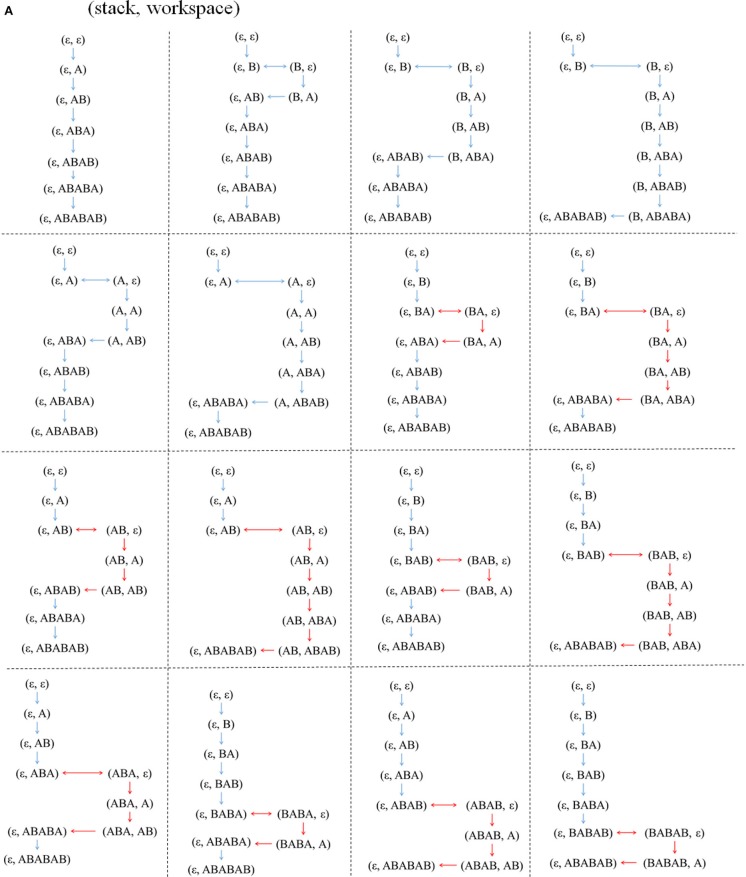
Examples (portion) of state transitions to make a product ABABAB using non-RCs (blue arrows) and RCs (red arrows). The notation (x, y) means that x is the stack state and y is the workspace state. Vertical arrows represent Get actions, and horizontal arrows represent Push (Rightward) or Pop (Leftward) actions. The table has no particular order. In case of other product than ABABAB, the ratio of state transition using RC changes. State transitions using the stack more than once are omitted.